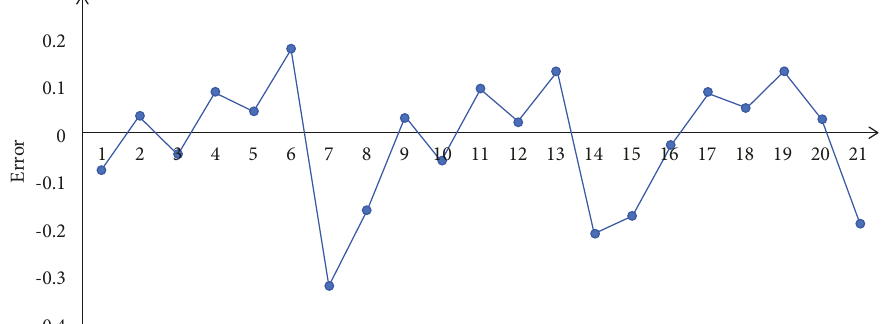
Figure 16: Warpage error